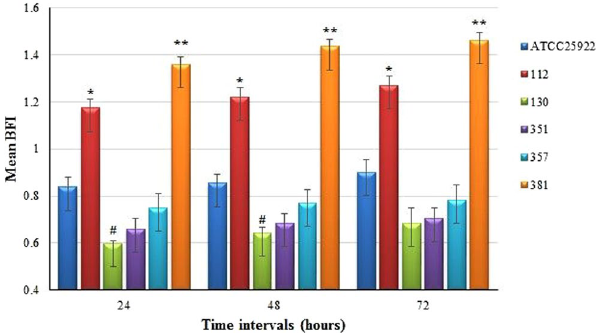
Figure 1. Biofilm formation of five isolates of E. coli and reference strain at different time intervals. The results are shown in the form of mean biofilm formation index (BFI) of three independent repeats and compared to E. coli ATCC 25922. Statistical significance (P ≤ 0.05) was calculated using two-tailed t-test. * P- values of ≤ 0.05 was considered significant higher than control. # P values of ≤ 0.05 was considered significant lower than control. ** P- values of ≤ 0.05 was considered significant higher than control and *